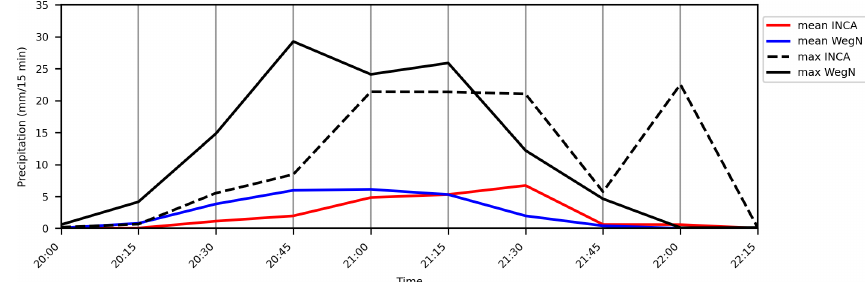
Figure 11. Time series of area-mean and maximum values in INCA and WegenerNet for the event on 18 May 2009.